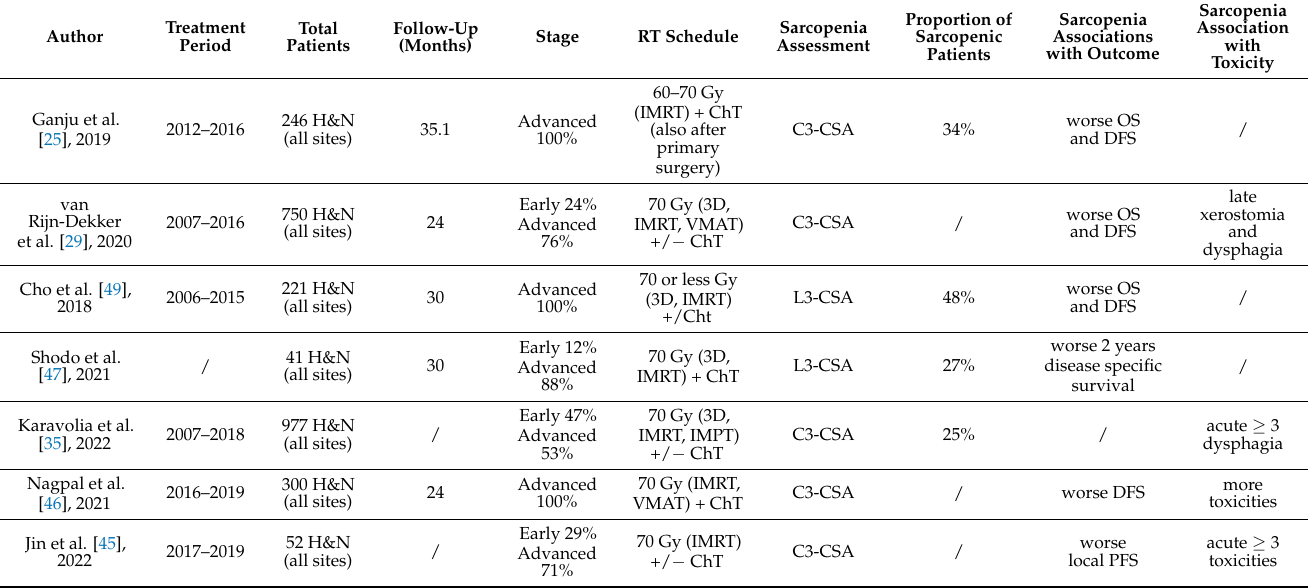
Table 3. Published retrospective studies on the association of sarcopenia with oncological and toxicity outcomes in patients with H&N